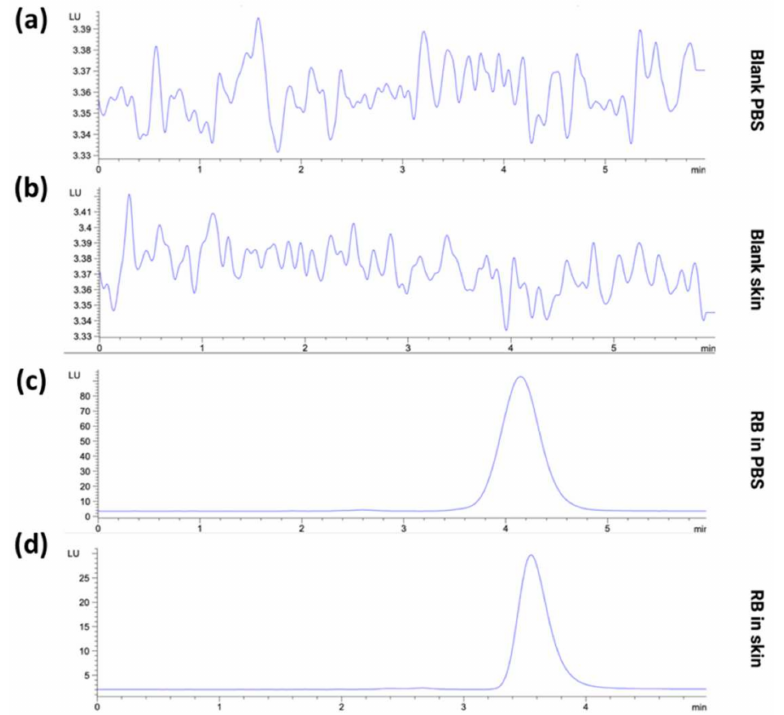
Figure 6. Representative HPLC-FD chromatogram of ( a ) blank PBS, ( b ) blank skin extract, ( c ) RB in PBS (10 µ g/mL) and ( d ) RB from skin extract (5 µ